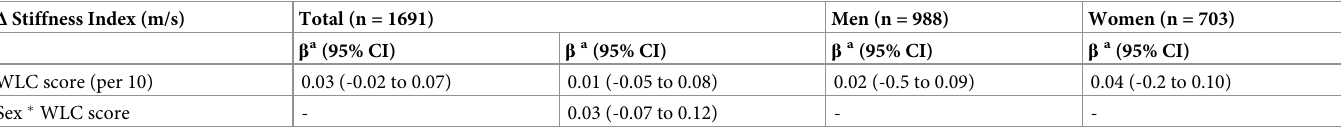
Table 4. Linear regression models of change in arterial stiffness index since baseline. Δ Stiffness Index